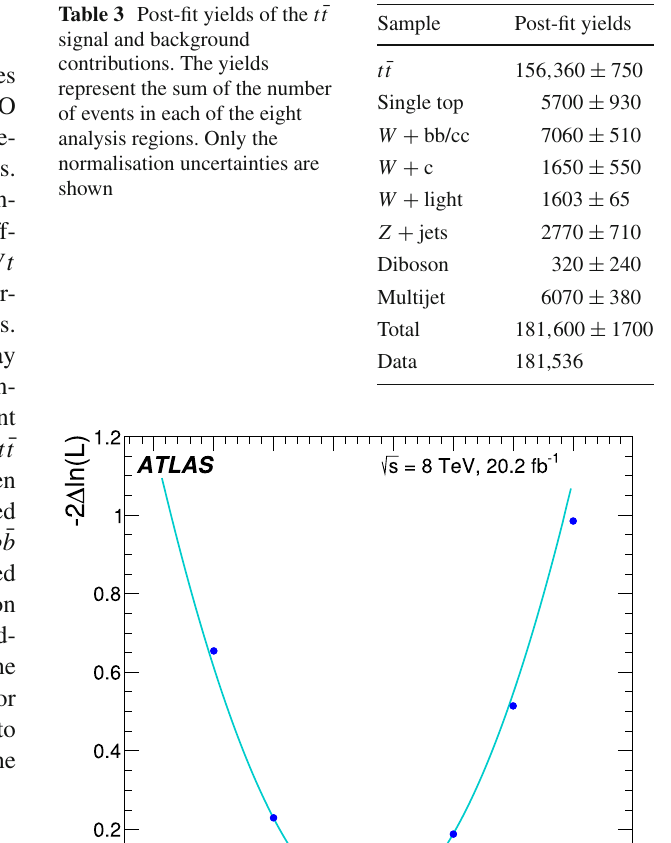
Table 3 Post-fit yields of the t ¯ t signal and background contributions. The yields represent the sum of the number of events in each of the eight analysis regions. Only the normalisation uncertainties are shown